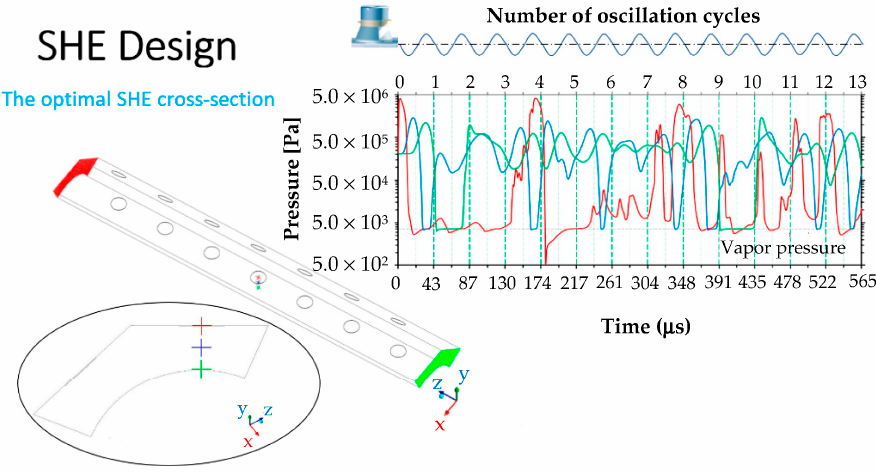
Figure 5. Determination of pressure transients inside the Sono-Heat-Exchanger—Olive Sound induced by the action of the ultrasound on the olive paste.